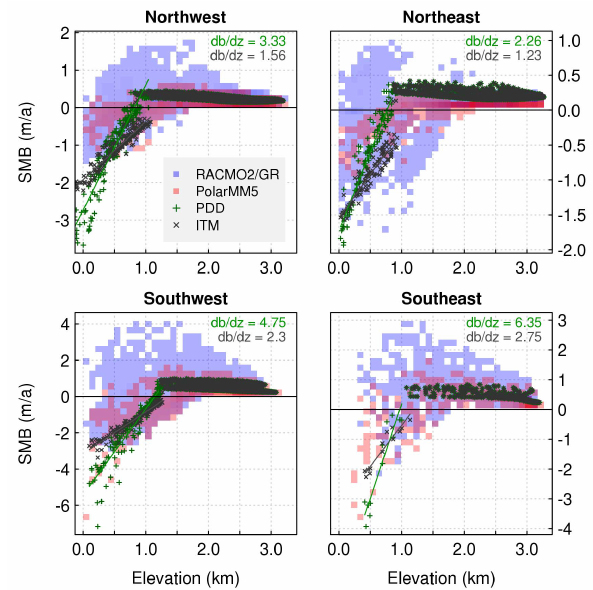
Figure 7. Diagnosed surface mass balance versus elevation by region for two RCMs and Fig. 7. Diagnosed surface mass balance versus elevation by region for two RCMs and REMBO using the PDD and ITM approaches. REMBO using the PDD and ITM approaches. The regions are defined as quadrants on The regions are defined as quadrants on Greenland with the origin near Summit ( − 39 ◦ E, 72 ◦ N). RACMO2/GR results (Ettema et al., Greenland with the origin near Summit (-39 °E, 72 °N). RACMO2/GR results (Ettema et al., 2009) and PolarMM5 results (Box et al., 2006) were binned to re- duce data density (blue and red squares, respectively), with darker 2009) and PolarMM5 results (Box et al., 2006) were binned to reduce data density, with squares indicating a higher density of points. Trendlines and the darker squares indicating a higher density of points. Trendlines and the slopes are shown for slopes are shown for the negative points of the PDD (green) and ITM (black) approaches. the negative points of the PDD and ITM approaches.